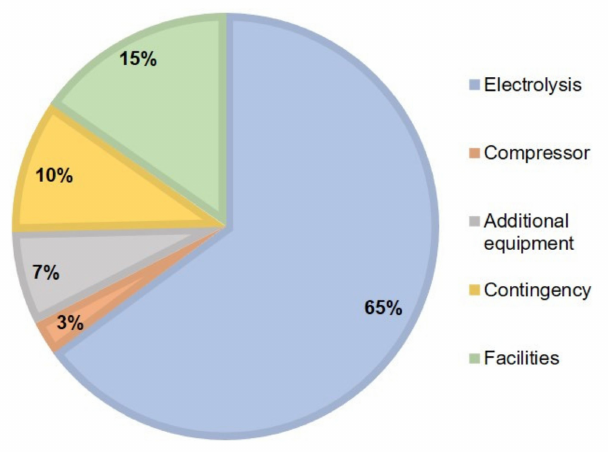
Figure 4. The CAPEX breakdown of the BEJF